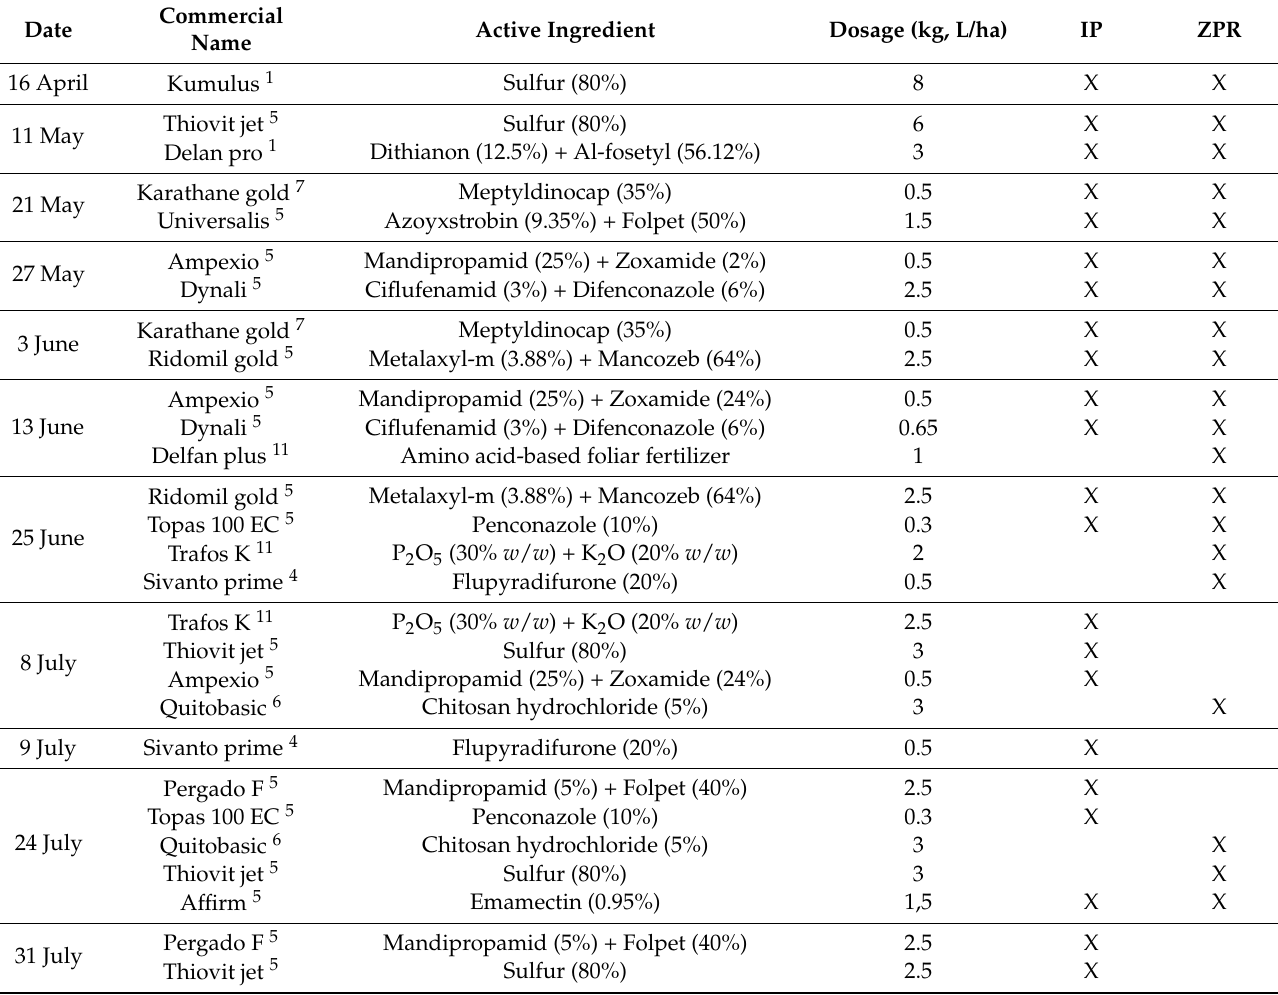
Table 3. Spray program for the Rebula vineyard in the 2021 season at integrated (IP) and 0-pesticide residue (ZPR) grape protection system. Preparation was applied if marked with